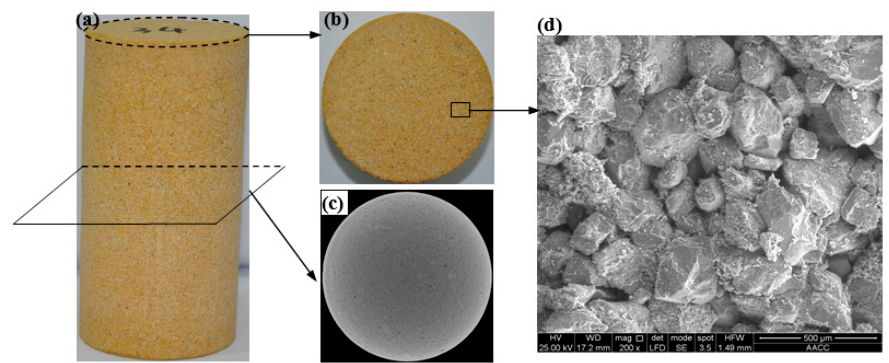
Figure 1. Sandstone specimen used for the present study. ( a ) Cylindrical sandstone specimen; ( b ) Surface digital photograph; ( c ) Cross-section by computerized tomography (CT) scanning; and ( d ) scanning electron microscopic (SEM) image.